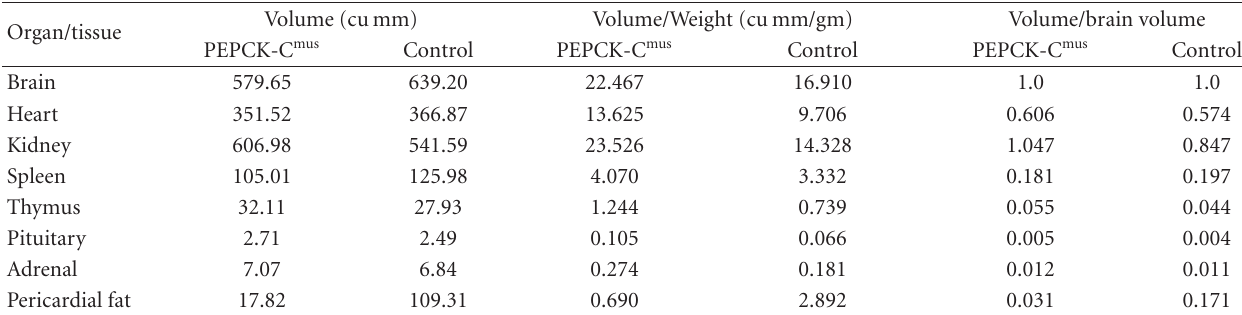
Table 1: Comparison of sizes of selected organs and tissues. Weight used is gross animal